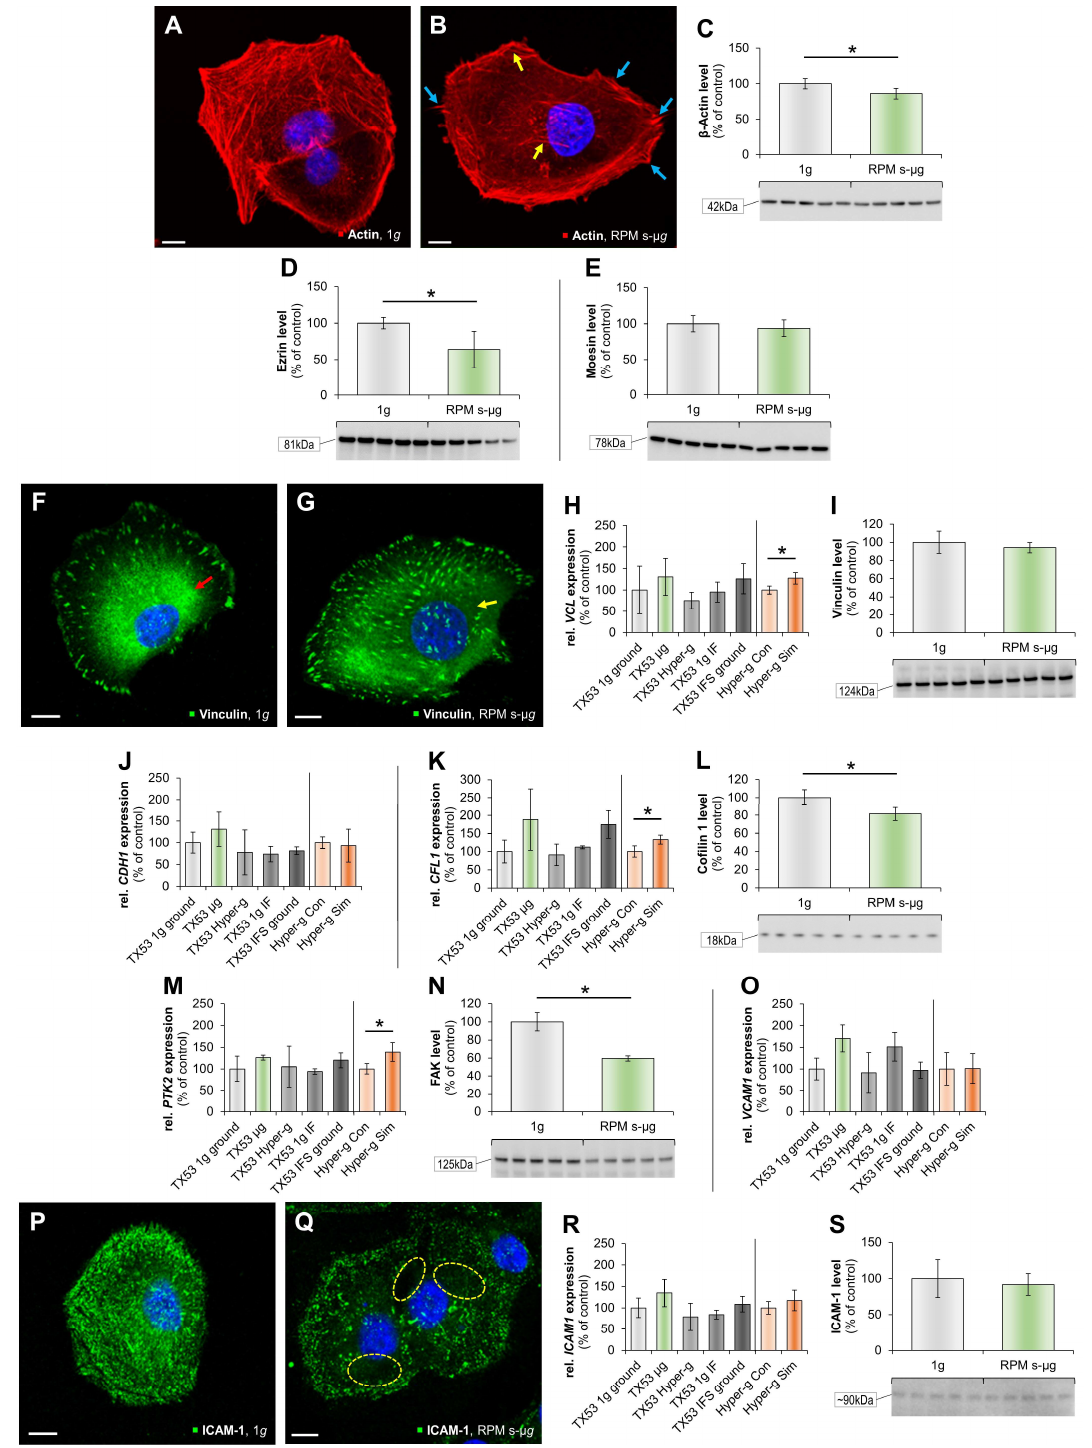
Figure 4. Histological staining of F-actin (red) and the nucleaus (blue) ( A , B ); yellow arrows: stress fibers and blue arrows: filopodia and lamellipodia; IFS of vinculin (green) and nucleus (blue) ( F , G ); red arrow: compact vinculin in 1 g around the nucleus and yellow arrow: redistributed vinculin in RPM-samples; ICAM-1 (green) and nucleus (blue); yellow circles: areas with no ICAM1-positivity in RPM-samples ( P , Q ); scale bar 10 µm. qPCR analyses of VCL ( H ), CDH1 ( J ), CFL1 ( K ), PTK2 ( M ), V CAM1 ( O ), ICAM1 ( R ), and WB of ACTB ( C ), ezrin ( D ), moesin ( E ), VCL ( I ), cofilin ( L ), FAK ( N ), ICAM1 ( S ). “TX53” indicates samples collected during the sounding rocket mission, whereas “Hyper-g” presents data from a parallel experiment aiming on the worst case-possible launch acceleration. IF: in-flight; Con: control; Sim: simulated; RPM: random positioning machine; 6min s- µ g ; * p < 0.05 vs.1 g , scale bars: 10 µm.